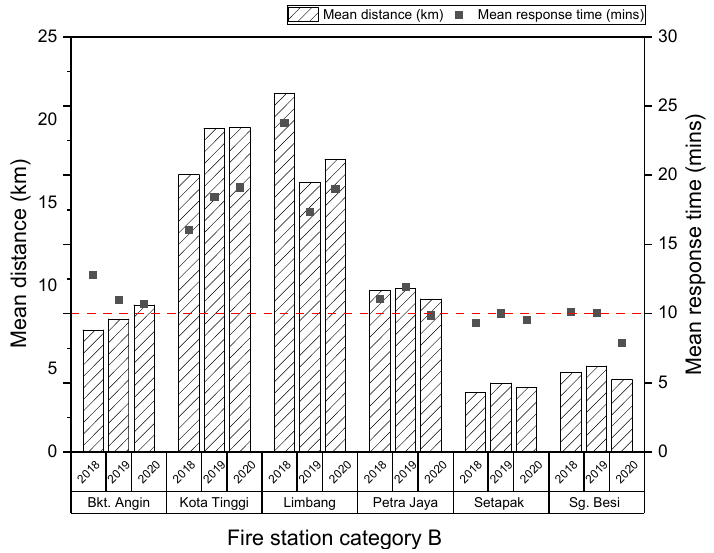
Figure 6. Mean distances travelled and response times recorded by category B fire stations. The red dash line is the mean response time benchmark for Malaysia.